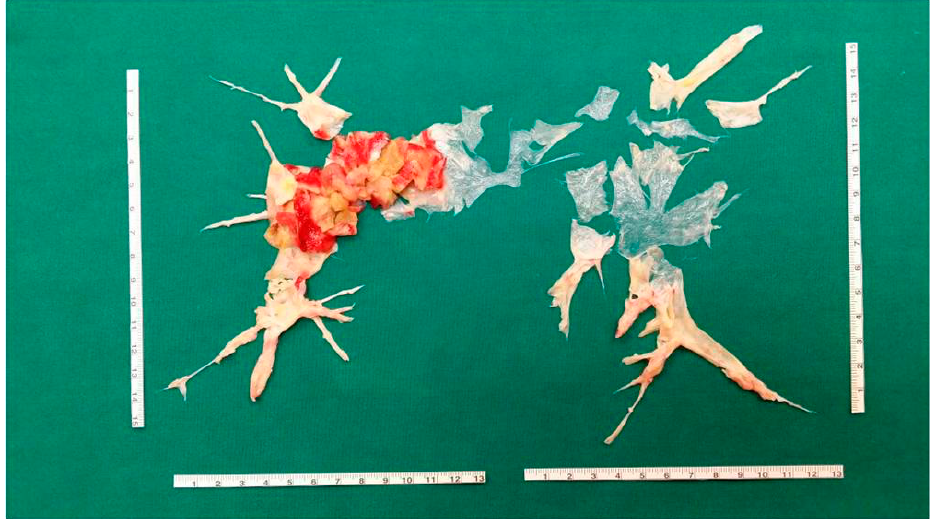
Figure 3. Pulmonary endarterectomy casts from a patient with complex and severe